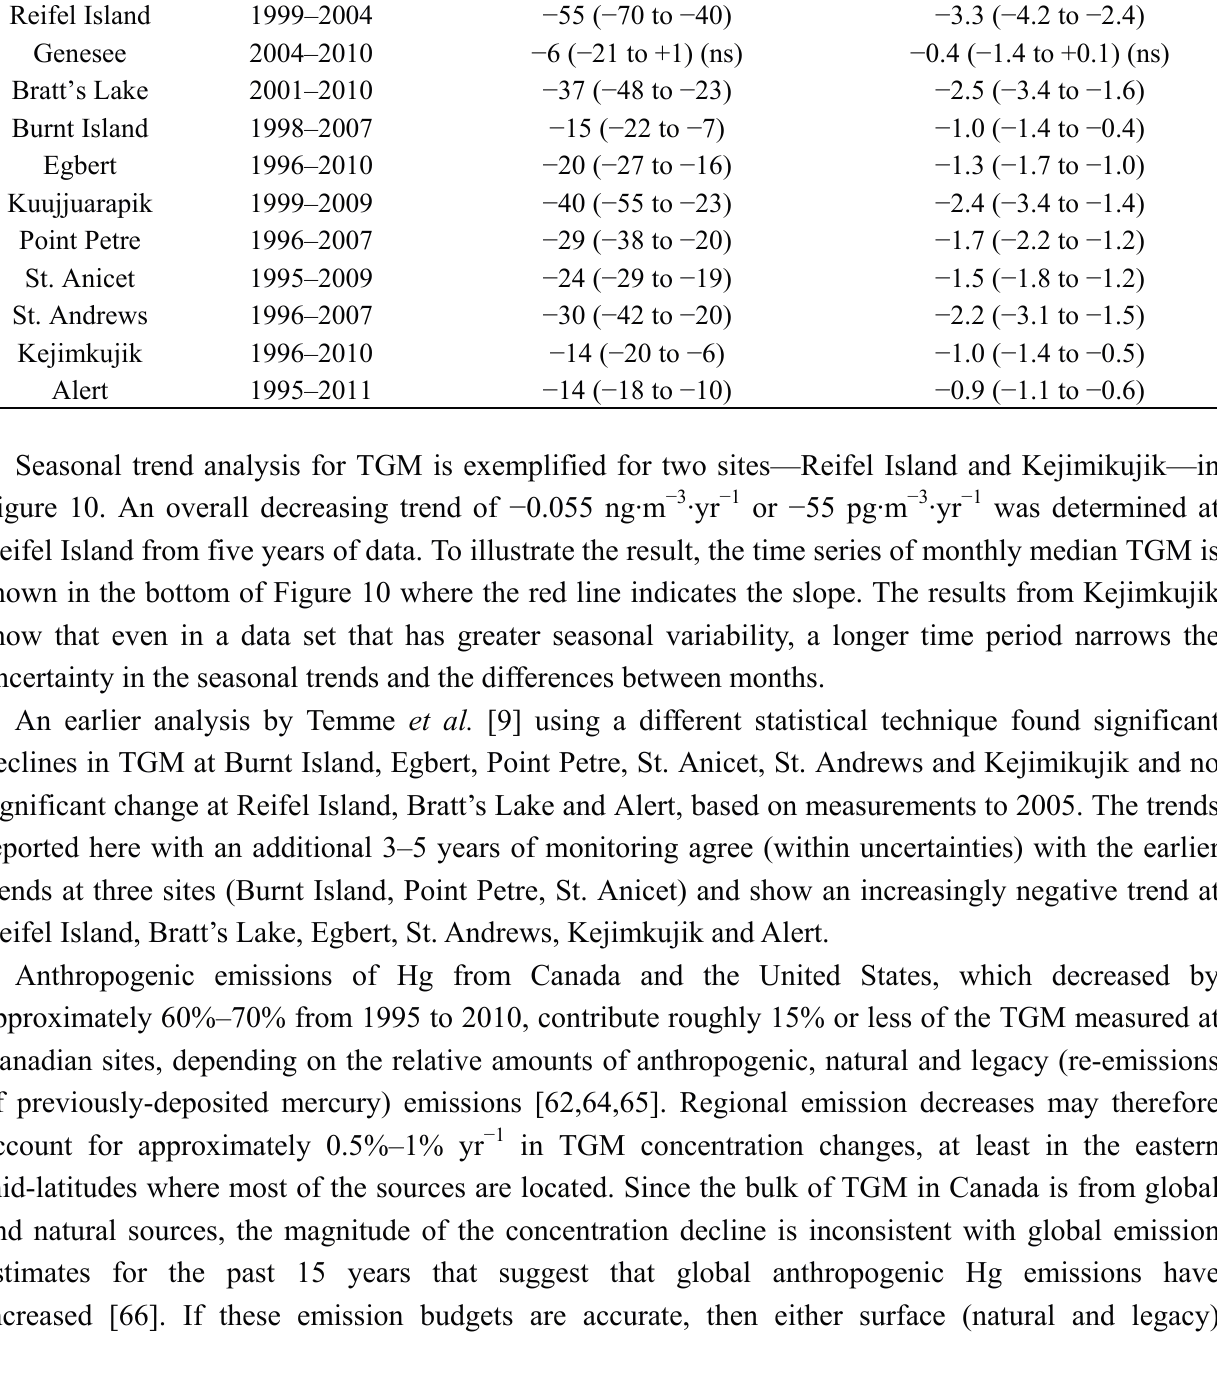
Table 4. TGM trends (and 95% confidence limits) at sites with >5 years of measurements.